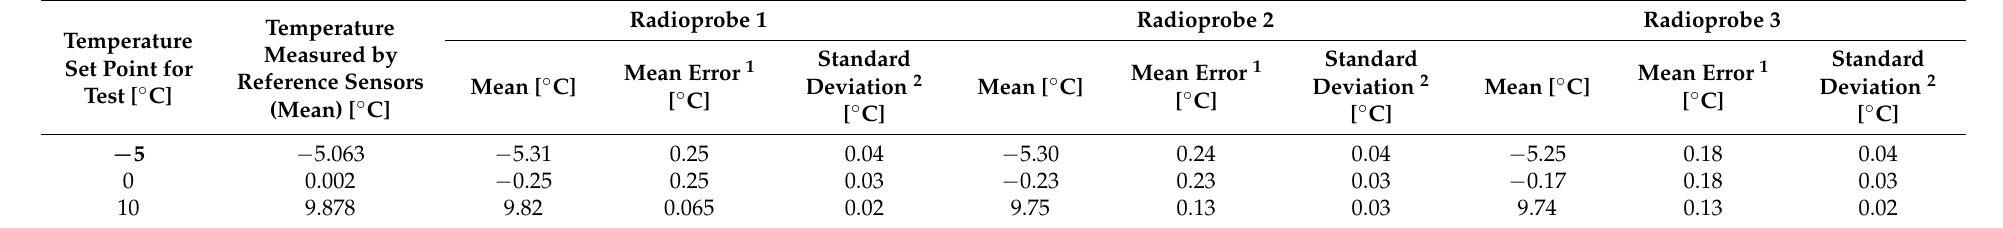
Table 4. Statistical comparison between radioprobe sensors and Italian National Metrology Institute (INRiM) reference sensors readings. Temperature. Temperature Set Point for Test is the temperature set to the climatic chamber. Temperature Set Point for Test [ ◦ C]